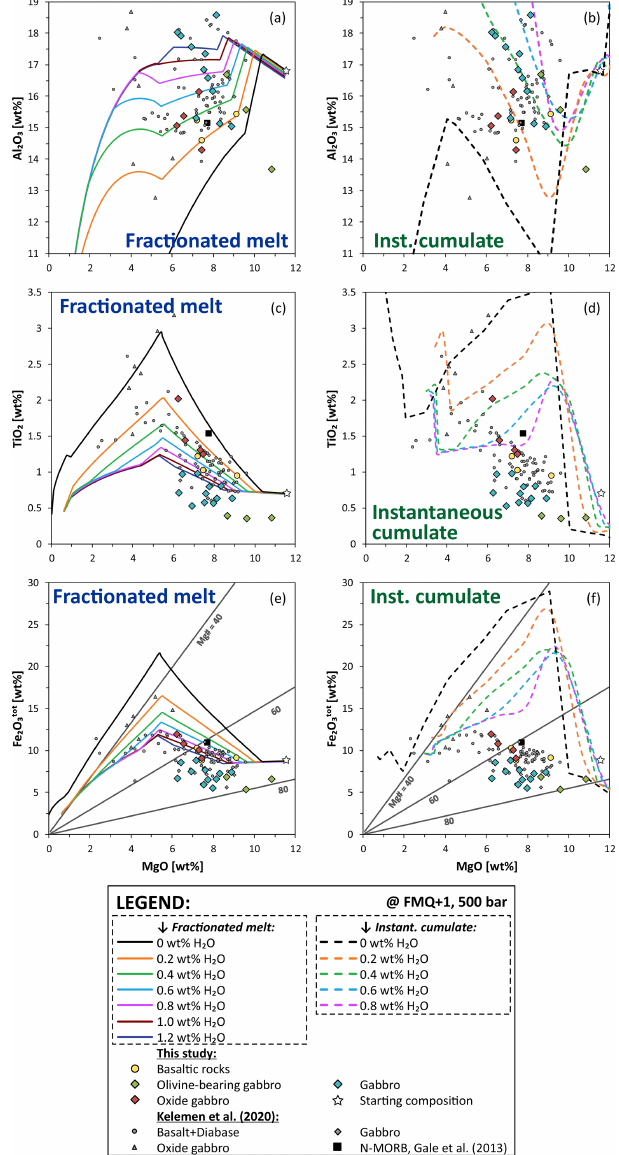
Figure 14. Al 2 O 3 , TiO 2 and Fe 2 O tot versus MgO for bulk major 3 element compositions of drill hole GT3A lithologies (data from this study and from Kelemen et al., 2020). (a, c, e) Solid lines repre- sent fractional crystallization modeling using MELTS for varying initial H 2 O contents. (b, d, f) Dashed lines represent the instanta- neous cumulate corresponding to the sum of the crystallized phases formed within a temperature interval of 20 ◦ C for different initial H 2 O contents. Starting composition is listed in Table 2. For details see